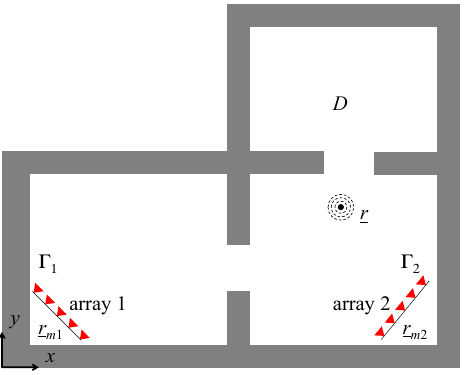
Figure 2. RF source localization with two receiving arrays. The arrays are located in different rooms and are tilted with respect to the x -axis.